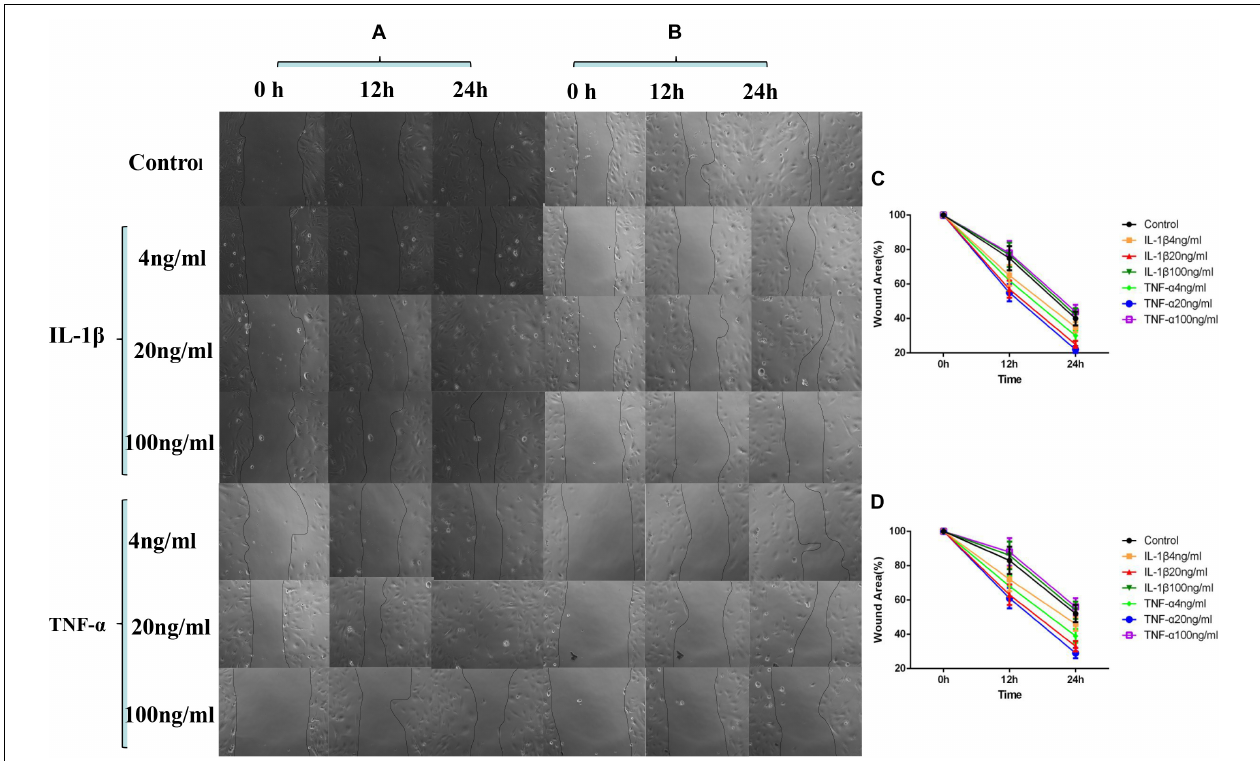
FIGURE 2 | Effects of IL-1 β and TNF- α on migration of vascular endothelial cells. The experimental results are expressed as mean ± standard deviation (SD); * indicates P < 0.05. (A) Samples without P311 siRNA intervention. (B) Samples with P311 siRNA intervention. (C) Statistical cell migration rate of A . (D) Statistical cell migration rate of B